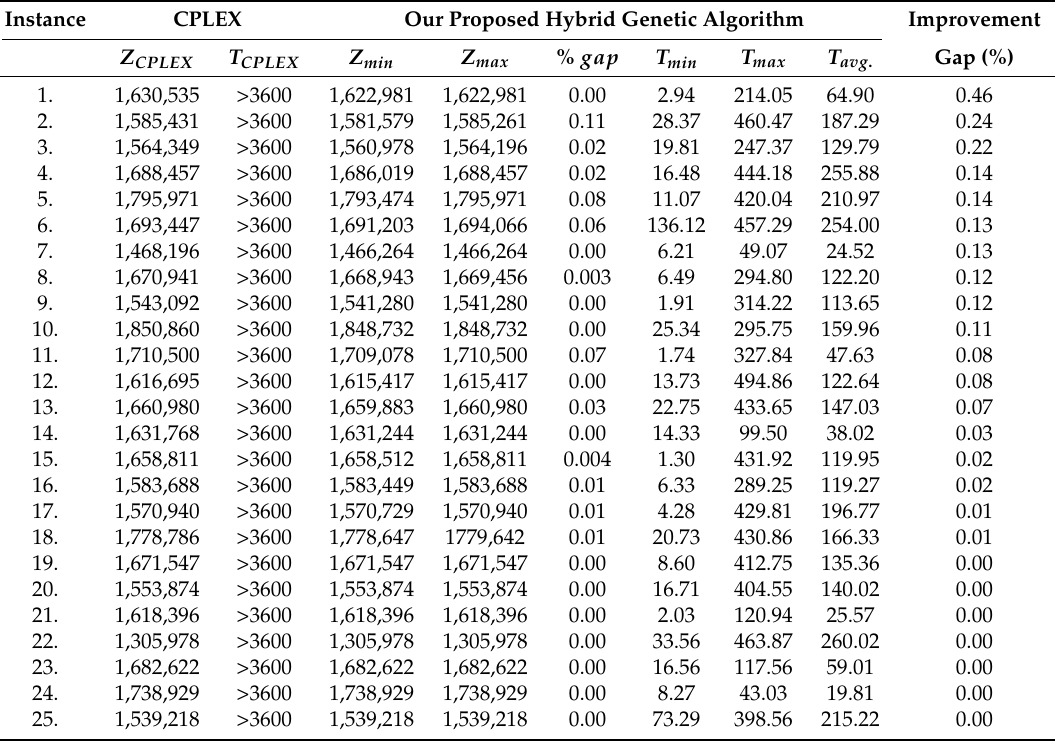
Table 4. Computational results achieved in the case of larger sized instances (8-12-25). Our Proposed Hybrid Genetic Algorithm